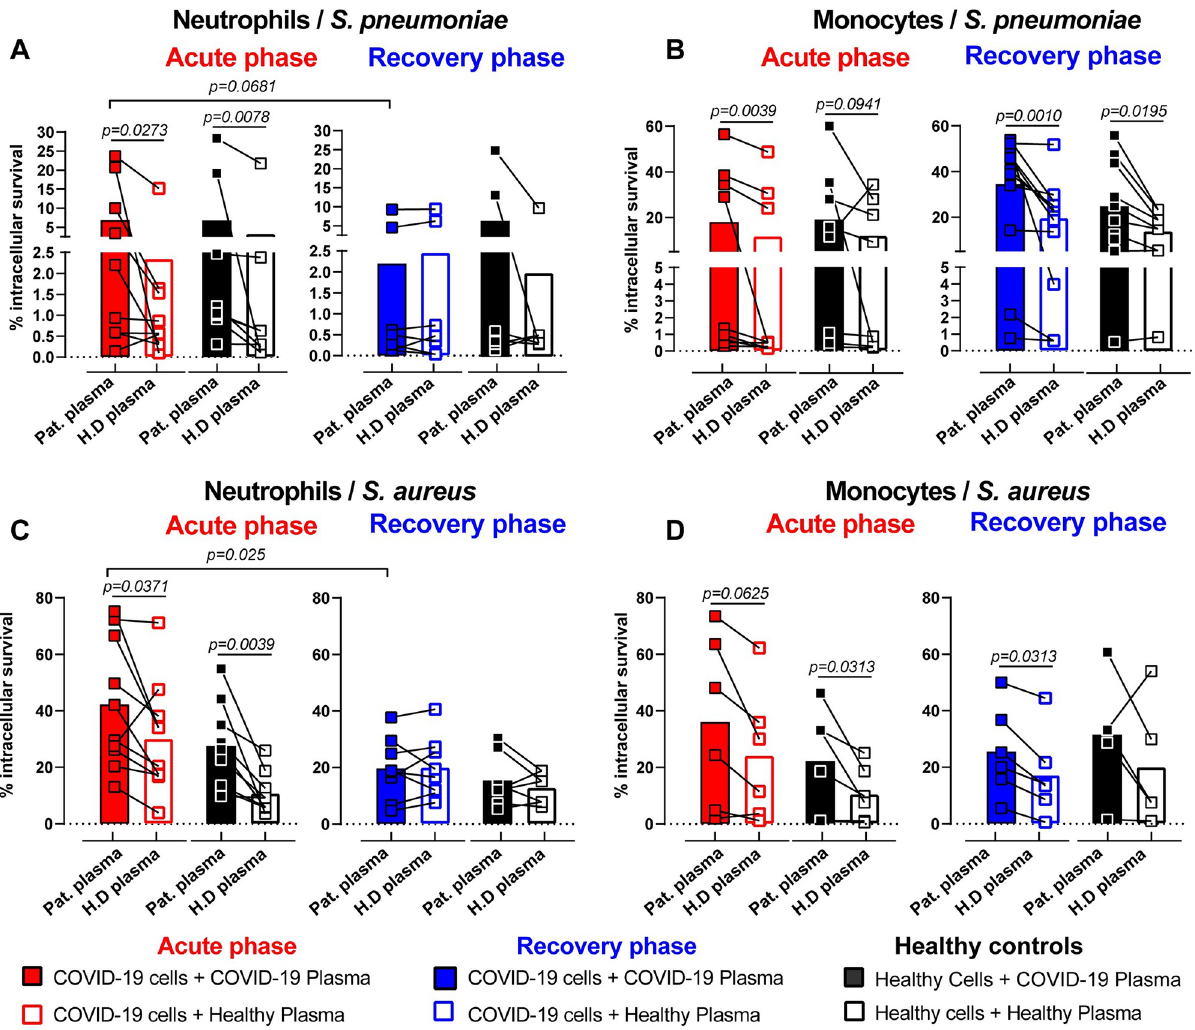
Fig 2. Impaired intracellular bactericidal capacity of innate immune cells in acute-phase COVID-19 patients. (A-D) Intracellular killing capacity of COVID-19 patient (acute-phase: red and rec-phase: blue) or healthy donor neutrophils (A and C) and monocytes (B and D) (n = 8–10) pre-exposed to 10% patient plasma (solid symbols) or healthy donor plasma (open symbols) for 3 h and subsequently infected with SP (A and B) or SA (C and D) at MOI 10. Neutrophils and monocytes were isolated freshly from blood and stimulated with the respective plasma conditions. Each symbol represents cells from one human subject, stimulated with either COVID-19 or healthy donor plasma from one donor. P values were determined by using Wilcoxon signed-rank test without adjustment for multiple